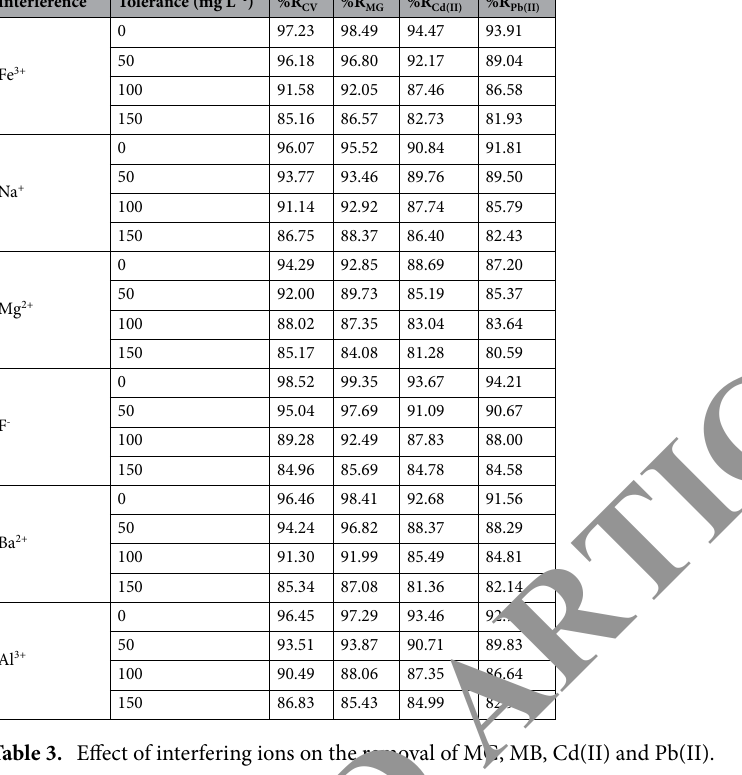
Table 3. Effect of interfering ions on the removal of MG, MB, Cd(II) and Pb(II).